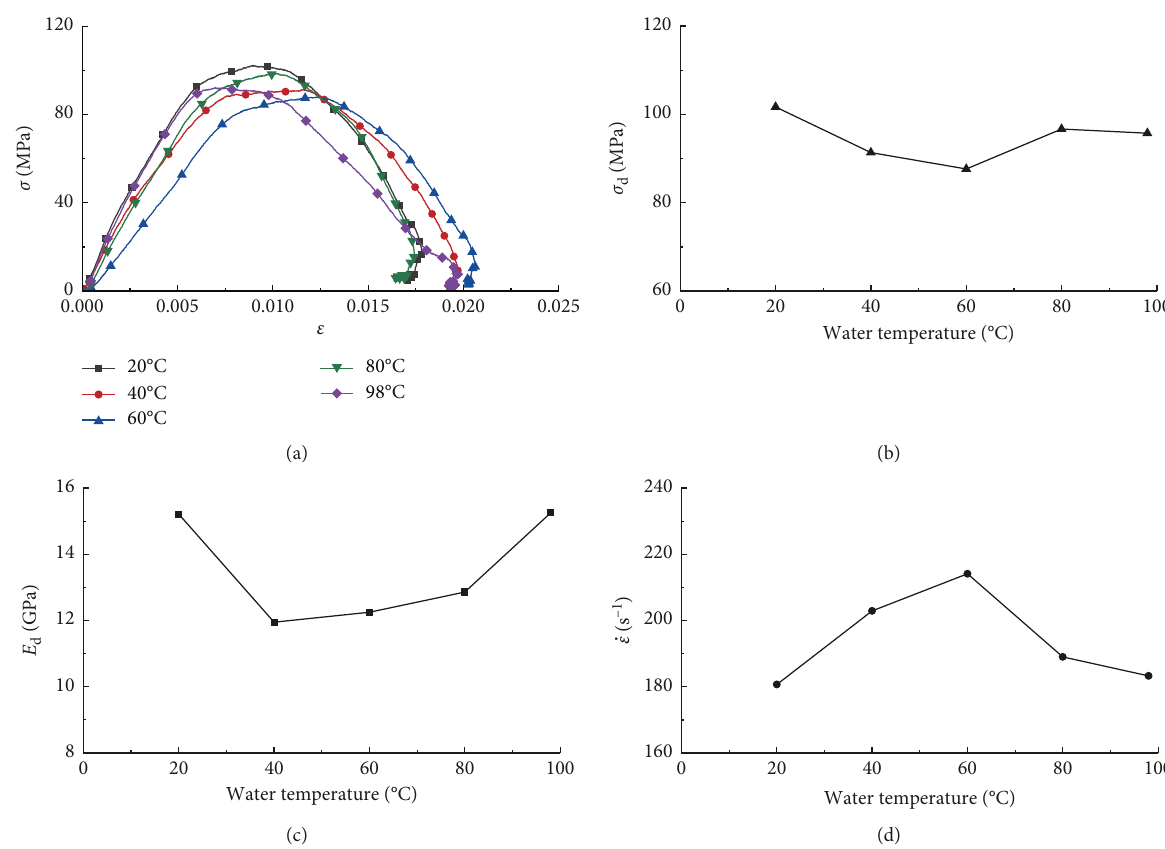
Figure 9: Dynamic uniaxial compressive characteristics variation versus water temperature. (a) Dynamic compressive stress-strain curve. (b) Dynamic uniaxial compressive strength. (c) Dynamic elastic modulus. (d) Average strain rate.